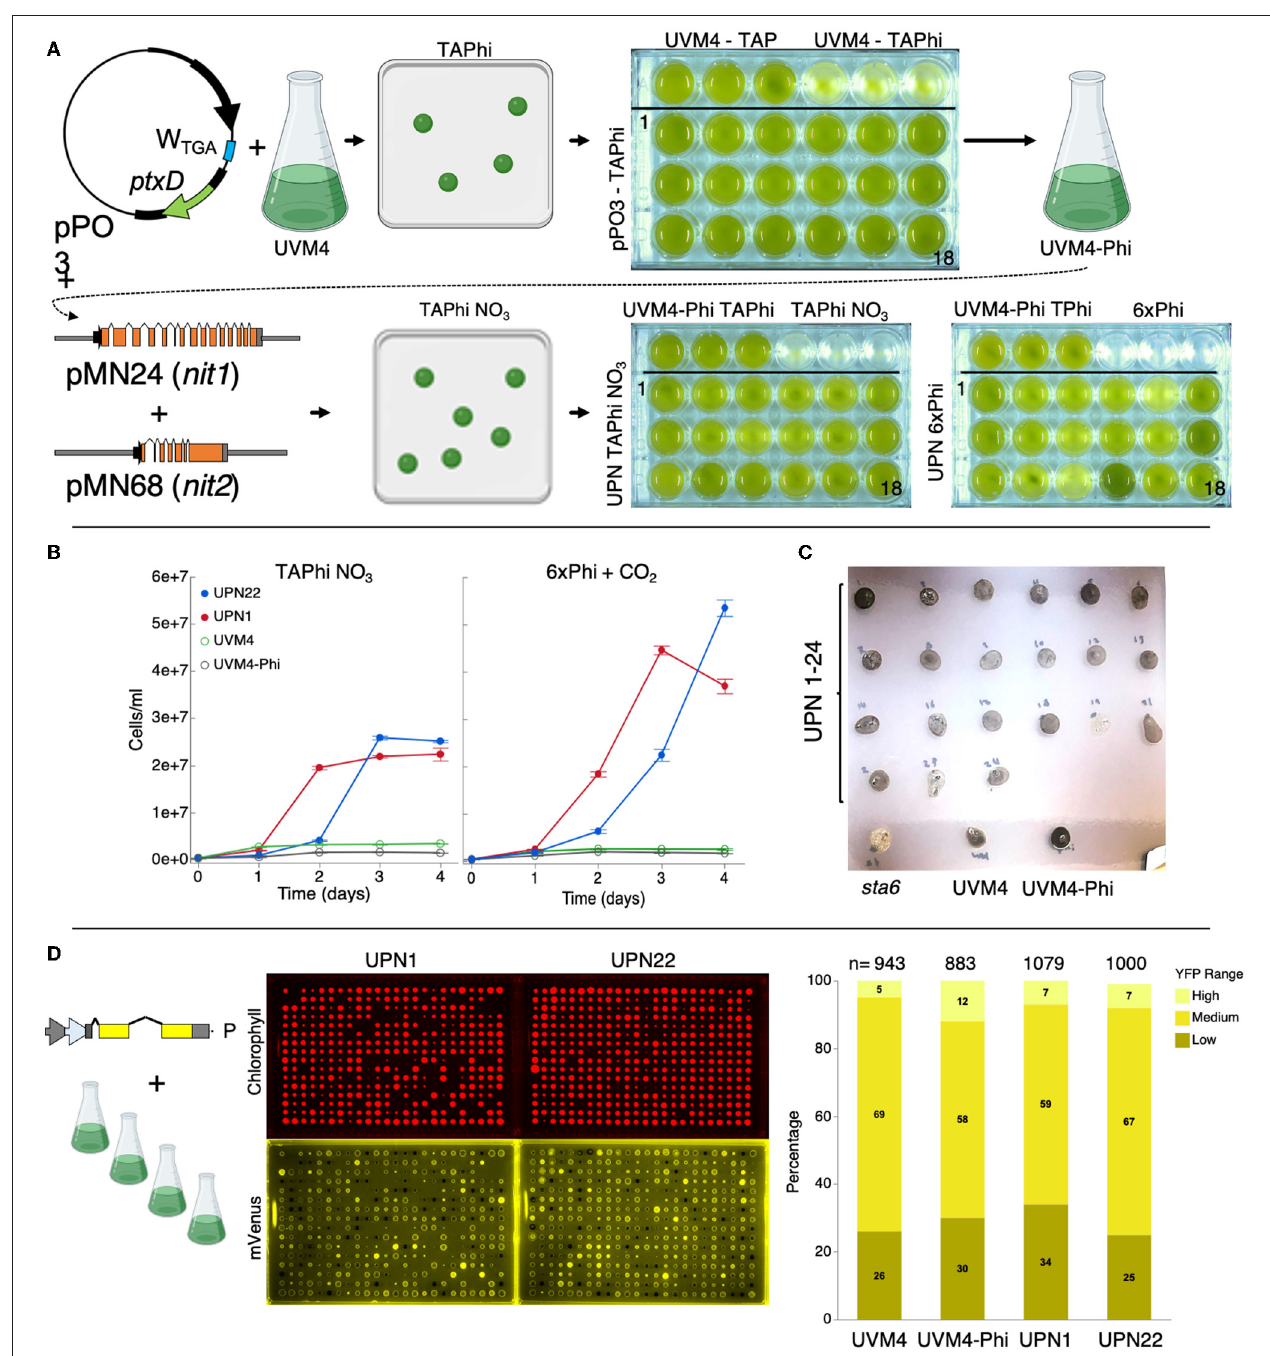
FIGURE 1 | Complementation of C. reinhardtii strain UVM4 for growth on phosphite and nitrate. (A) Plasmid pPO3 (Changko et al., 2020) was transformed into UVM4, and colonies were recovered on a TAPhi agar medium. Colonies were then cultivated in a TAPhi liquid medium, and one strain (UVM4-Phi) was selected for further complementation with pMN24 (Fernández et al., 1989) and pMN68 (Schnell and Lefebvre, 1993) ( nit1 / nit2 ) plasmids. Selection was performed on TAPhi-NO 3 plates, and resultant colonies capable of growth on phosphite and nitrate (UPN) were cultivated in liquid mixotrophic (TAPhi-NO 3 ) and autotrophic (6xPhi) media. Parental strains were grown as reference in each previous stage media as shown. (B) Growth curves of liquid cultures of selected colonies, which performed well in TAPhi-NO 3 or 6xPhi media. Cell concentrations represent the mean ( ± standard error mean) of three biological replicates per condition, each measured in three technical replicates. Parental strains UVM4 and UVM4-Phi were not able to proliferate in the nitrate phosphite-containing media. (C) UPN strains were investigated by iodine vapor staining at the agar plate level to determine if the transformation of three plasmids above had caused background mutations in starch synthesis. Dark color of colonies indicates presence of starch; yellow or light color indicates perturbed starch metabolism as shown for the starchless sta6